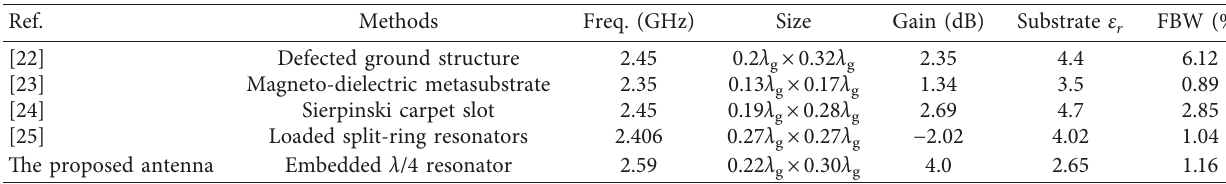
Table 3: Comparison of various compact MAs.